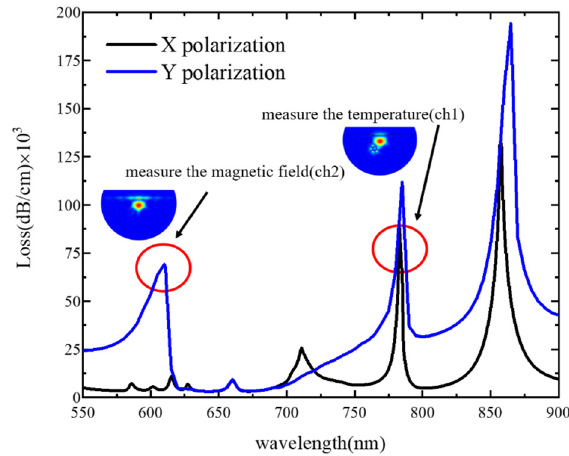
Figure 2. The loss spectrum of core mode X polarization and Y polarization. As plotted in Figure 2, there are three peaks for X polarization. Because the PDMS in Channel 1 is not affected by the magnetic field intensity, the first and second peaks are only temperature sensitive and the loss of the second peak is higher. The SPPs in the second peak of X polarization are selected as the SPP modes of Channel 1. There are three peaks for Y polarization, and the second and third peaks are sensitive to temperature and magnetic field, while the first peak is only sensitive to magnetic field, so the SPPs at the first peak in Y polarization are selected as the SPP modes of Channel 2. In Channel 2, the SPP modes appear near the gold film on the polishing surface. The energy loss of the core mode reaches the maximum and the SPR effect is excited. Thus, part of the energy of the core mode is coupled to the SPP modes of Channel 2, and bright spots appear at the junction of the Channel 2 metal film and the analyte, which has a strong field distribution. In Channel 1, the SPP modes appear near the air hole of the gold film. The energy loss of the core mode reaches the maximum and the SPR effect is excited. Part of the energy of the core mode is coupled to the SPP modes of Channel 1, and bright spots appear at the junction of effect is excited, the energy limiting ability of the core is weakened, and part of the energy of the core will be coupled to the metal SPP modes. Therefore, the loss peak of the core mode will appear at the resonance